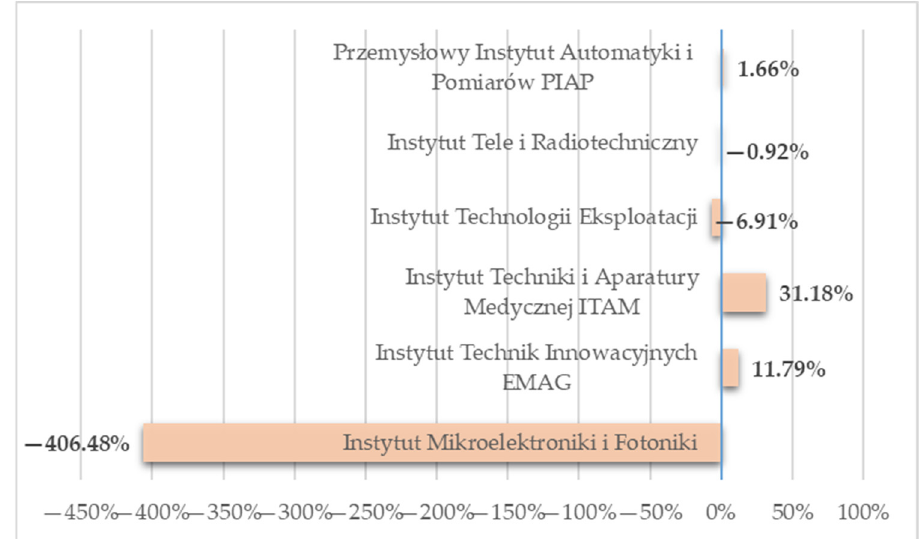
Figure 3. Change in sales revenue at researched institutes over the period 2019–2020 [in %]. Source: [97].